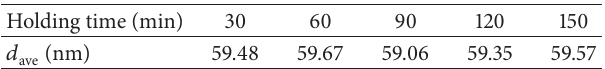
Table 2: Average crystallite size of samples synthesized for different times.